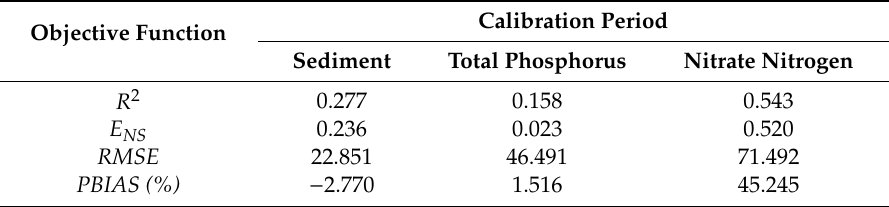
Table 9. Statistical evaluation of simulated daily sediment load and total phosphorus and nitrate nitrogen loads for the calibration period (2008–2009) at the Kožbanjšˇcek stream main